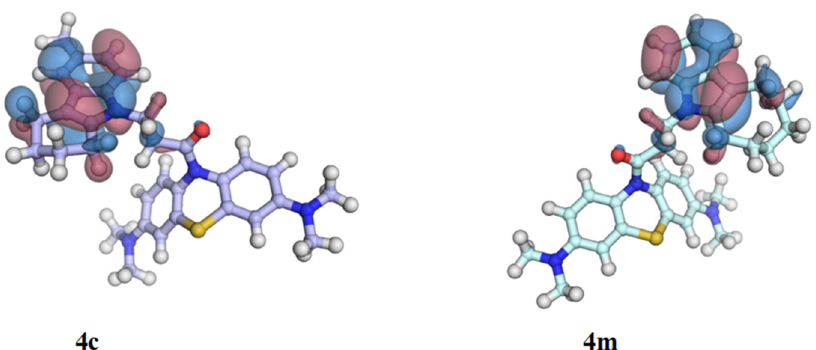
Figure 3. Highest occupied molecular orbital (HOMO) of conjugates 4c ( n = 2) and 4m ( n = 4). Areas of positive and negative signs of the molecular orbital wave function are colored red and blue, respectively. The isovalue surface is 0.01 e · Bohr − 3 .